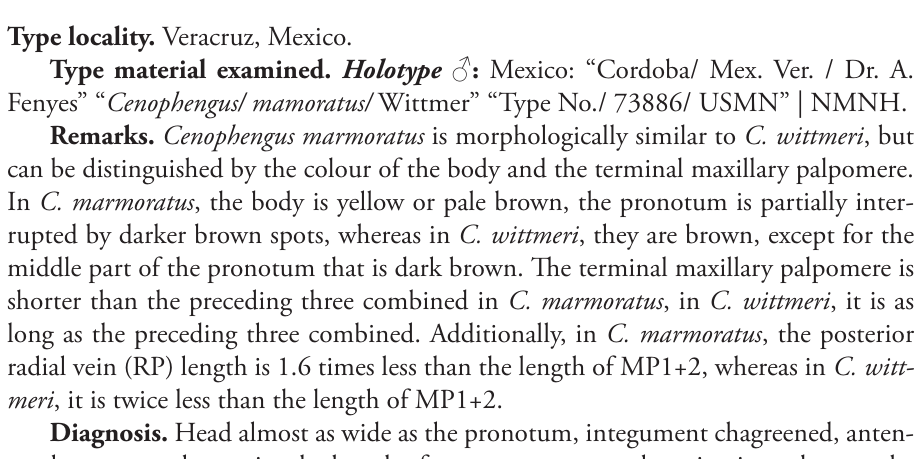
Fig. 17A–H Cenophengus marmoratus Wittmer, 1976: 453. Type locality. Veracruz,